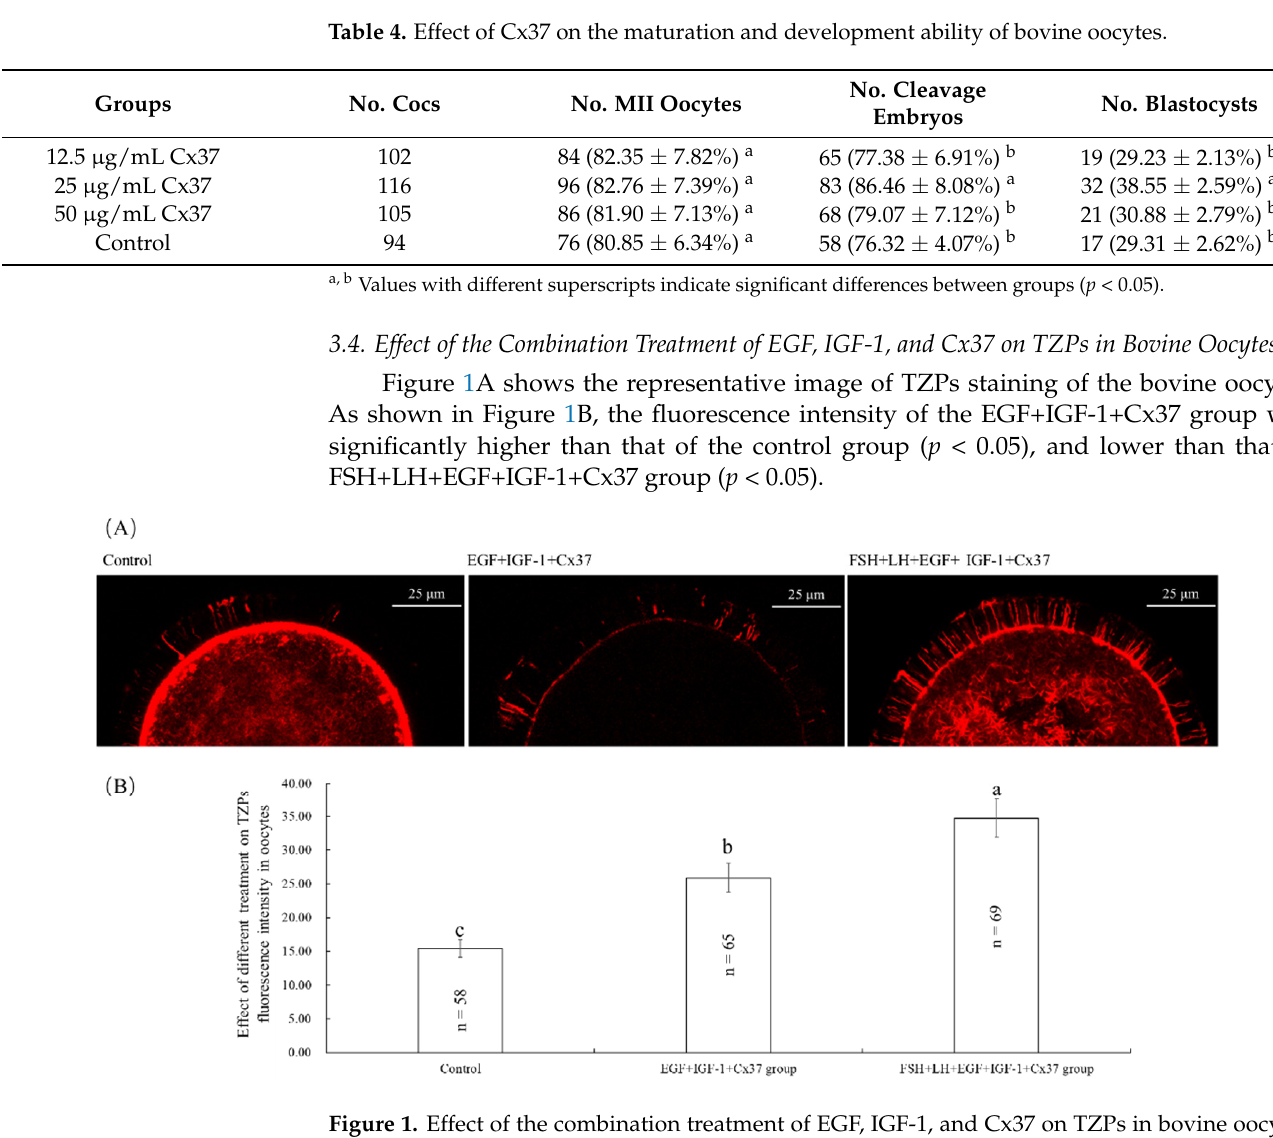
Table 4. Effect of Cx37 on the maturation and development ability of bovine oocytes.